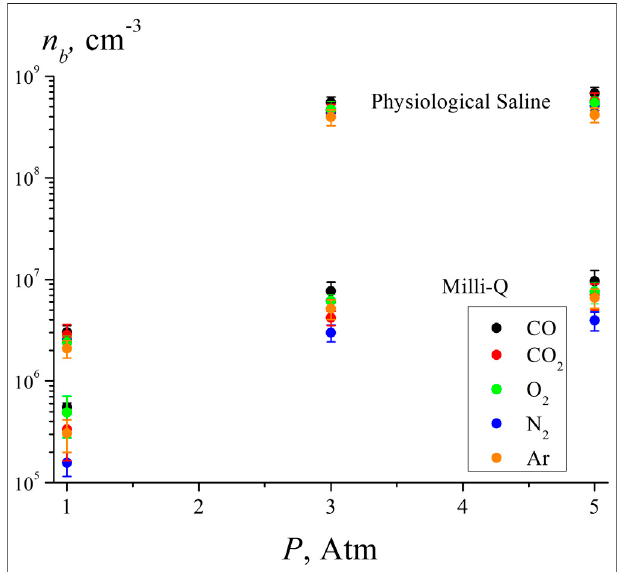
FIGURE 5 | Volume number density of bubstons according to the DLS experiment in water and saline solution for various gases at pressures of 1, 3, and 5